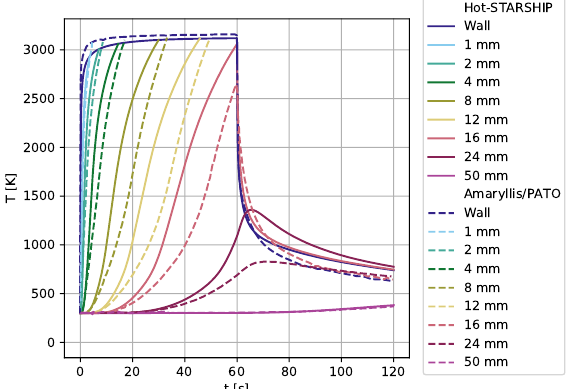
Figure A2. Comparison of Hot-STARSHIP and Amaryllis/PATO temperature